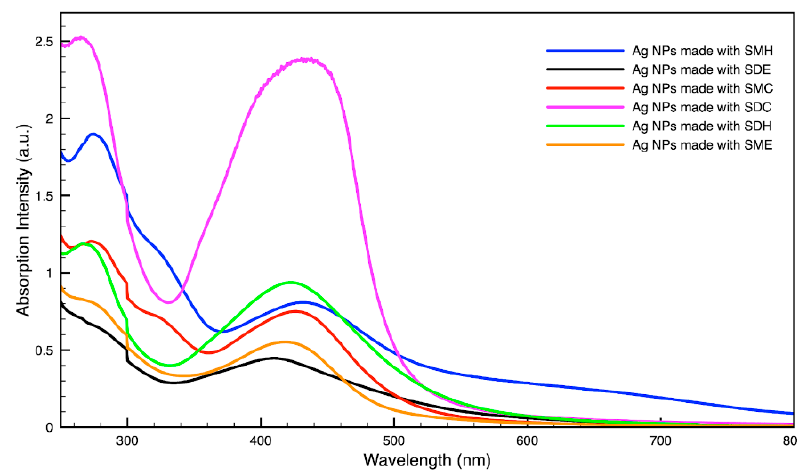
Figure 5. Absorption spectrum of silver (Ag) nanoparticles (NPs) synthesized using various forms of spent coffee ground extract.